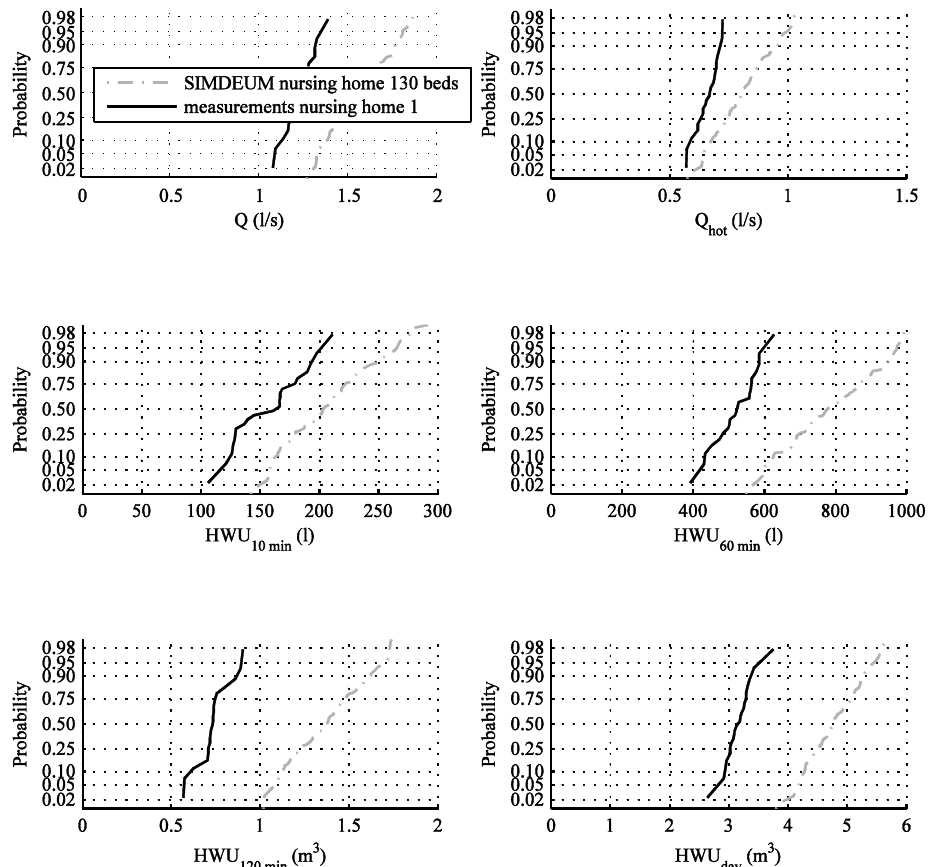
Figure 2. Frequency distribution of measured (26 weekdays at 1s scale) and simulated (100 days at 1s scale) peak demand values for nursing home I: (a) MMF cold [Ls − 1 ], (b) MMF hot [Ls − 1 ], (c) HWU 10 [L], (d) HWU 60 [L], (e) HWU 120 [m 3 ], (f) HWU day [m 3